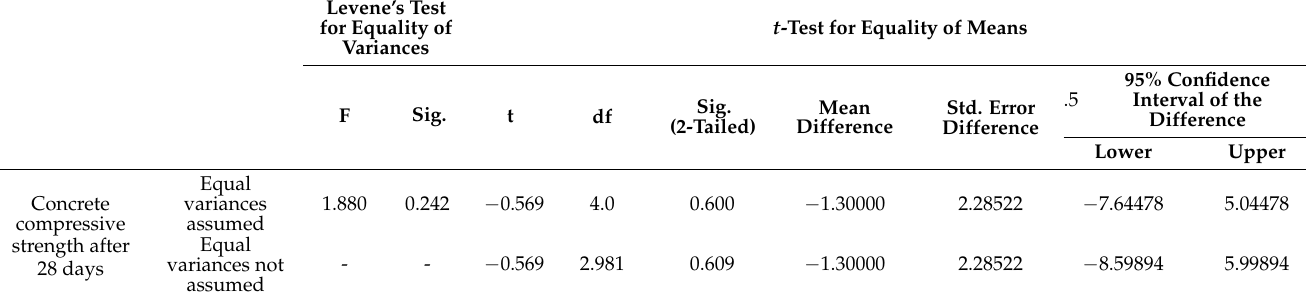
Table 13. Independent t -test for concrete compressive strength after 28 days.